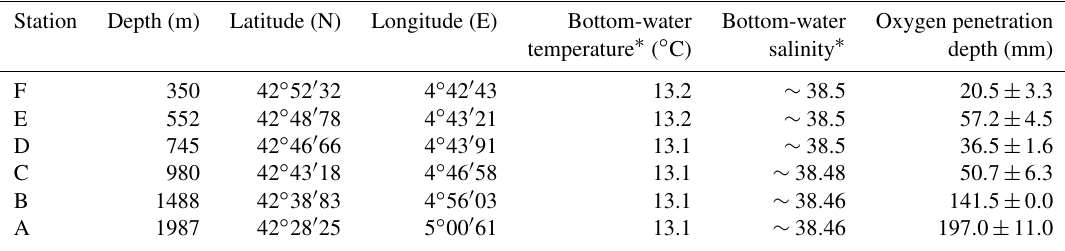
Table 1. Water depth, coordinates, and bottom-water physiochemical parameters: temperature ( ◦ C), salinity, and oxygen penetration depth (mm) for six stations